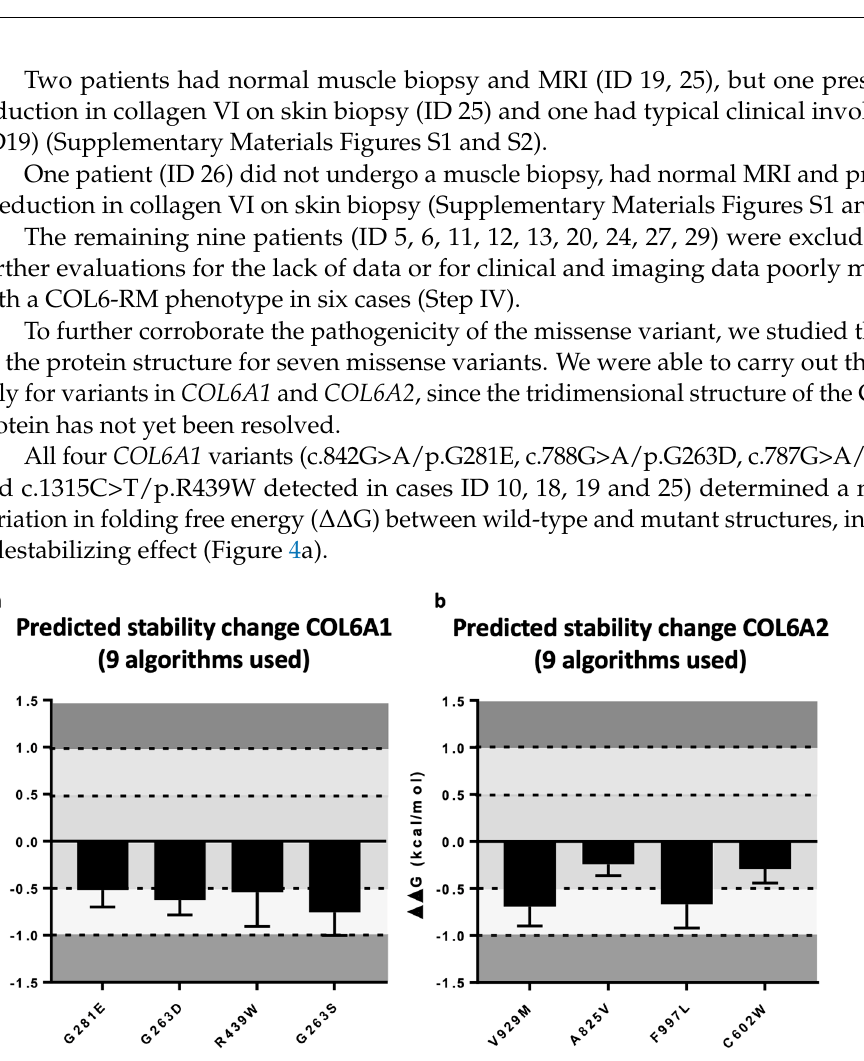
Figure 4. Representation of the prediction change in stability of subunits A1 ( a ) and A2 ( b ) of COLVI due to the missense identified in this study. Variation in folding free energy ( ∆∆ G) is predictors of protein stability changes upon single-point variations: ∆∆ G > 1.0 indicate a probable stabilizing effect; 0.5 < ∆∆ G < 1.0 indicate a likely stabilizing effect; − 0.5 < ∆∆ G < 0.5 indicate no significant change in stability; − 1.0 < ∆∆ G < − 0.5 indicate a likely destabilizing effect; ∆∆ G < − 1.0 indicate a probable destabilizing